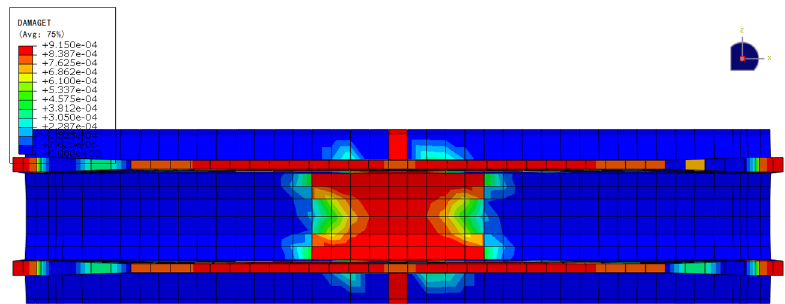
Figure 24. The damage nephogram of the S1 model after 2 million fatigue cycles.